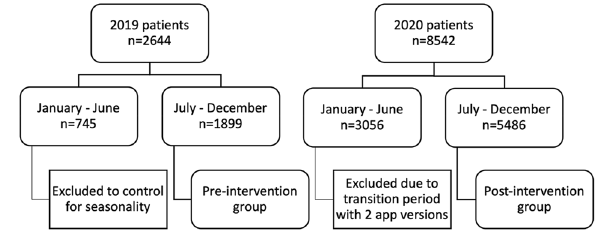
Figure 1. Flowchart of the included